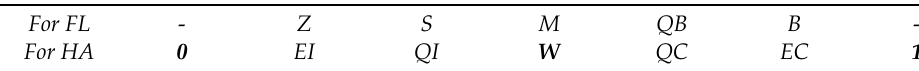
Table 3. Term transformation of the linguistic values.